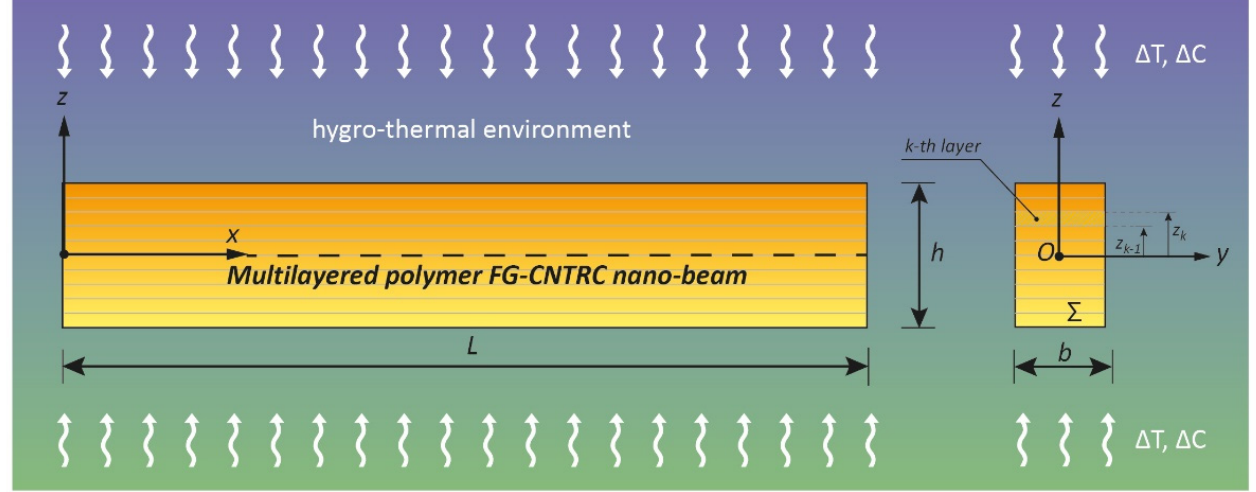
Figure 1. Coordinate system and configuration of a multilayered FG-CNTRC nano-beam subjected to a hygro-thermal environment.